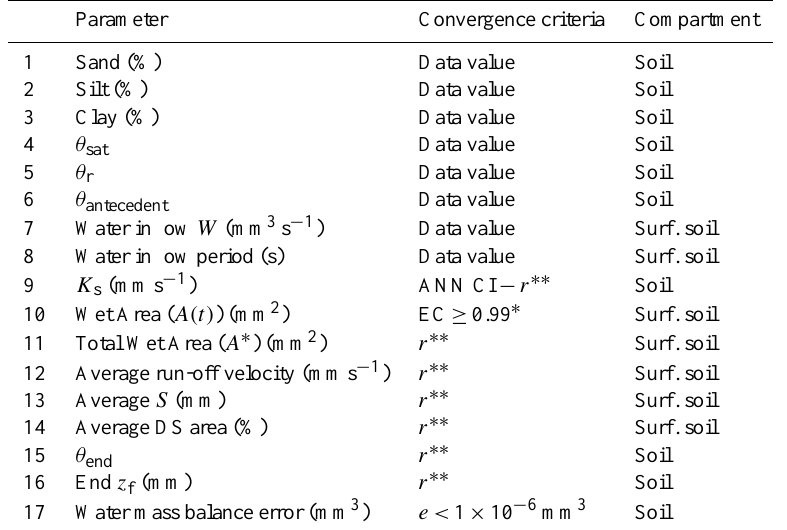
Table 1. Calibration parameters and variables of soil surface and upper vadose and convergence criteria used in tuning a model of the field plot experiments. ANN CI: Confidence interval of the ANN estimation process; r : correlation coefficient, linear regression model-data values ( x model = a + b × x data ; H 0 : a =0, b =1) over all plot experiments. ( A(t) ): convergence evaluated at 10–15 times during the water inflow period ( ∗∗ : statistical significance at P <